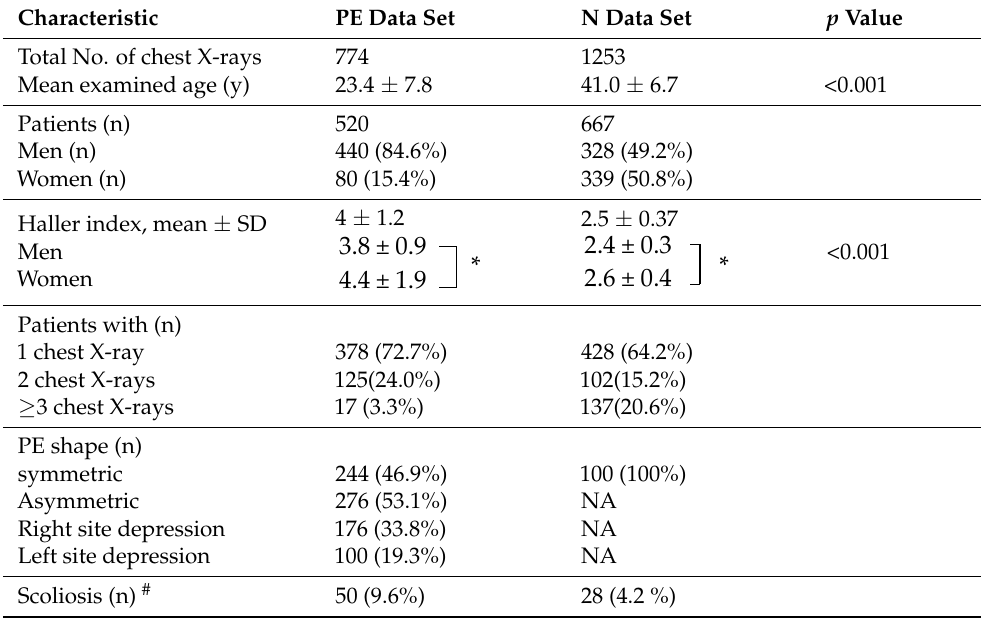
Table 2. Patient characteristics of the Training and Test Data Sets.